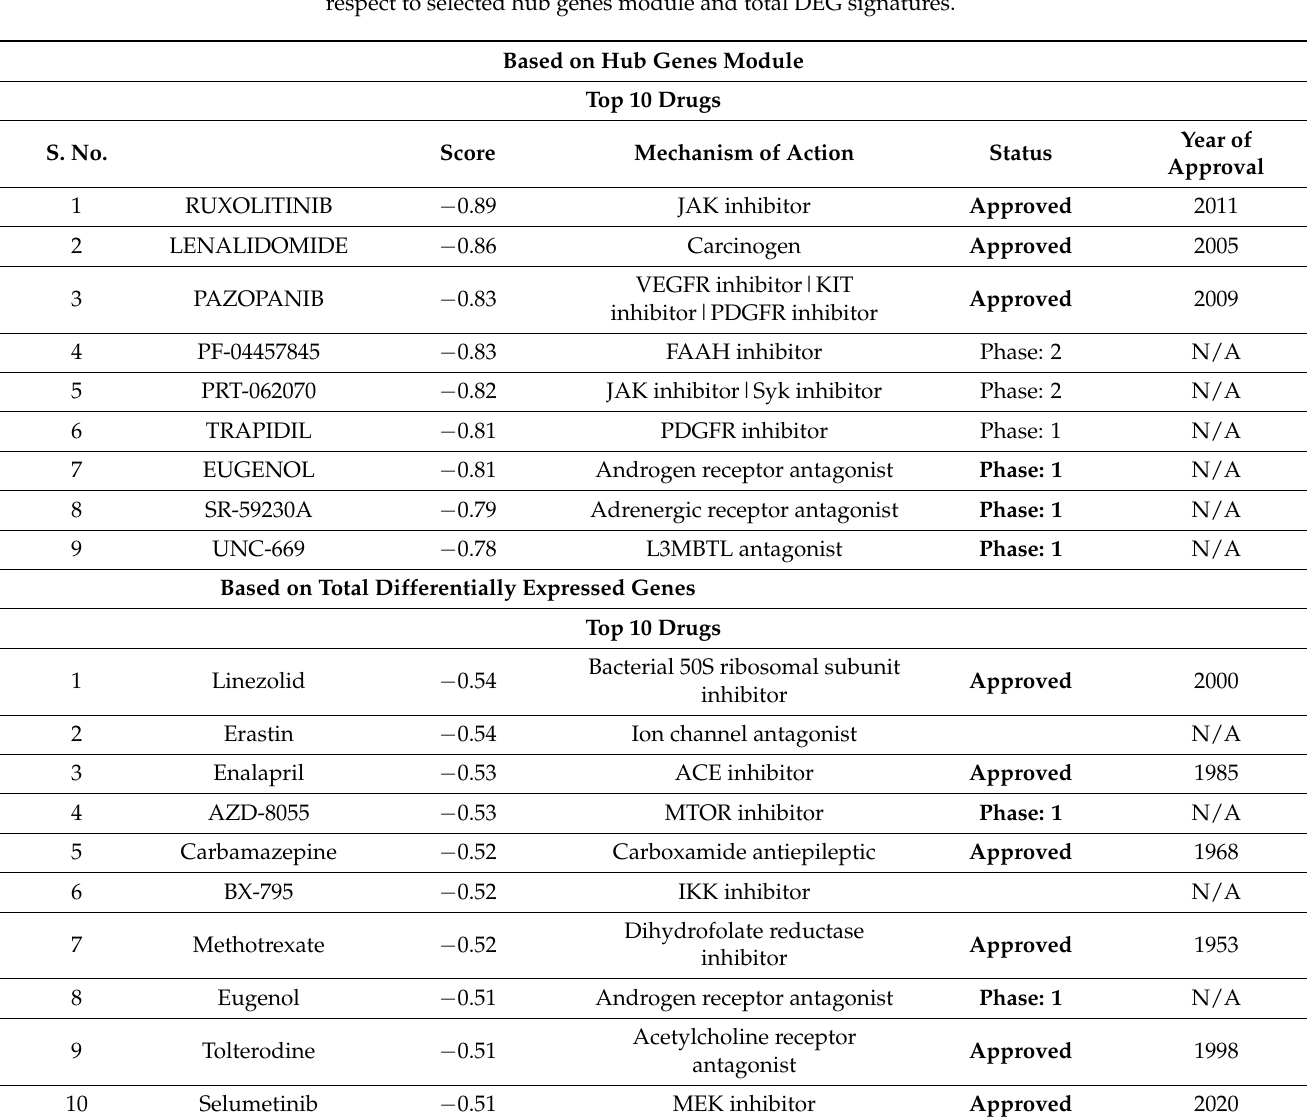
Table 5. Top 10 compounds with high negative correlations for COVID-19–GBM association with respect to selected hub genes module and total DEG